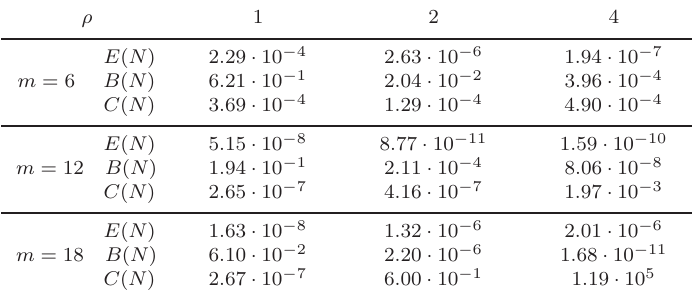
Table 6. E ( N ) , B ( N ) and C ( N ) corresponding to α opt,ρ , N opt,ρ for f ( x ) from (6.2). ρ 1